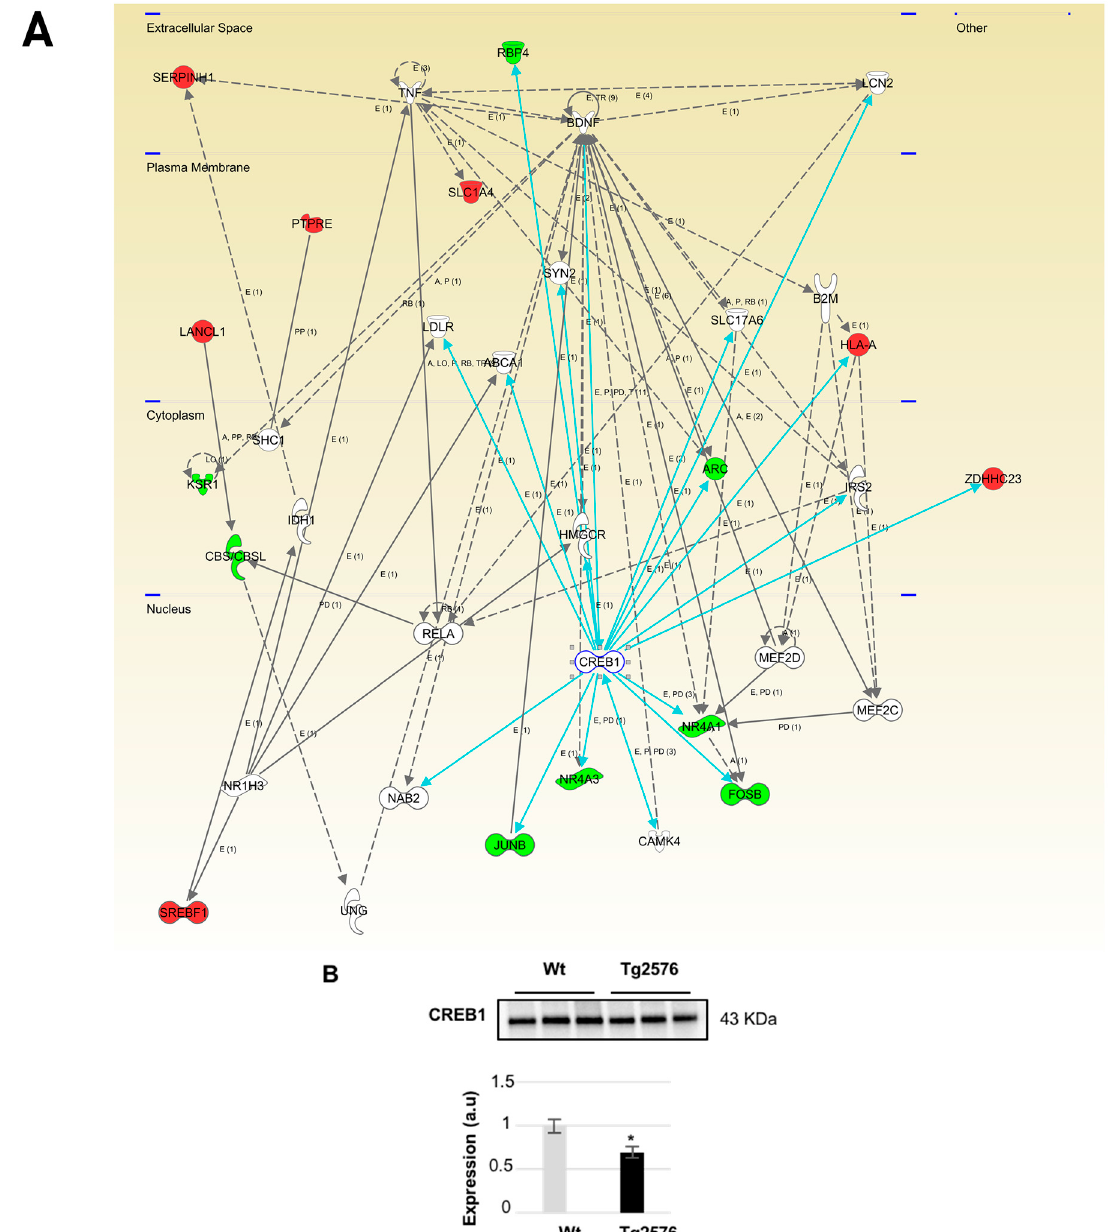
Figure 6. Modulation of CREB1 molecular interactome in the OB of aged Tg2576 mice. Visual representation of the relationships between differential expressed genes/proteins and CREB1 functional interactors (blue lines) are shown in the deregulated network in Tg2576 OBs ( A ); Continuous lines represent direct interactions, while discontinuous lines correspond to indirect functional interactions. Up-regulated molecules are shown in red, down-regulated molecules in green, and molecules proposed by the software in white. The complete legend of this type of interactomes may be found at http://ingenuity.force.com/ipa/articles/Feature_Description/Legend (accessed on 17 October 2017). CREB1 protein levels were down-regulated in the OB of aged Tg2576 mice. * p < 0.05 vs. WT group ( B ). Equal loading control and quantitation values have been included in Table S5. a.u., arbitrary units.